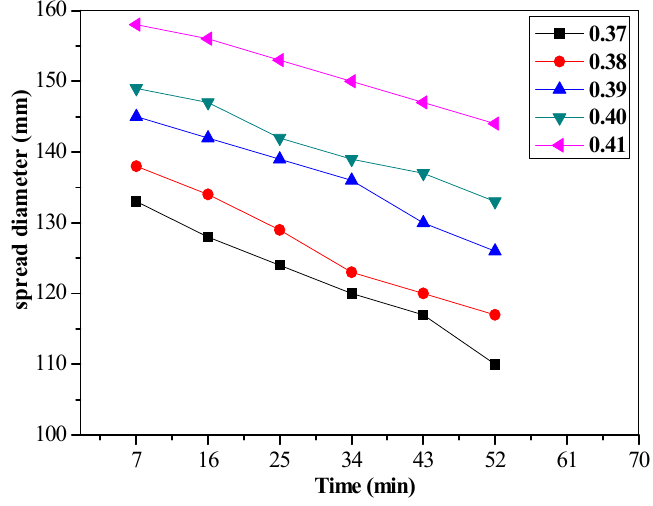
Figure 9. Spread diameter versus time.